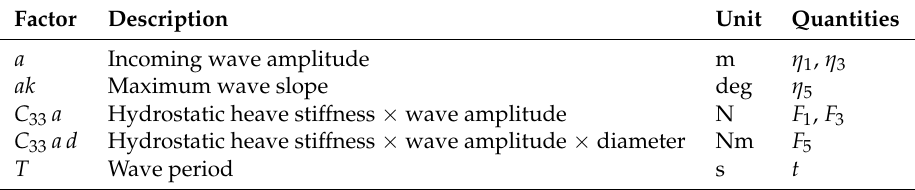
Table 4. Overview of the non-dimensionalisation factors used in results. Factor